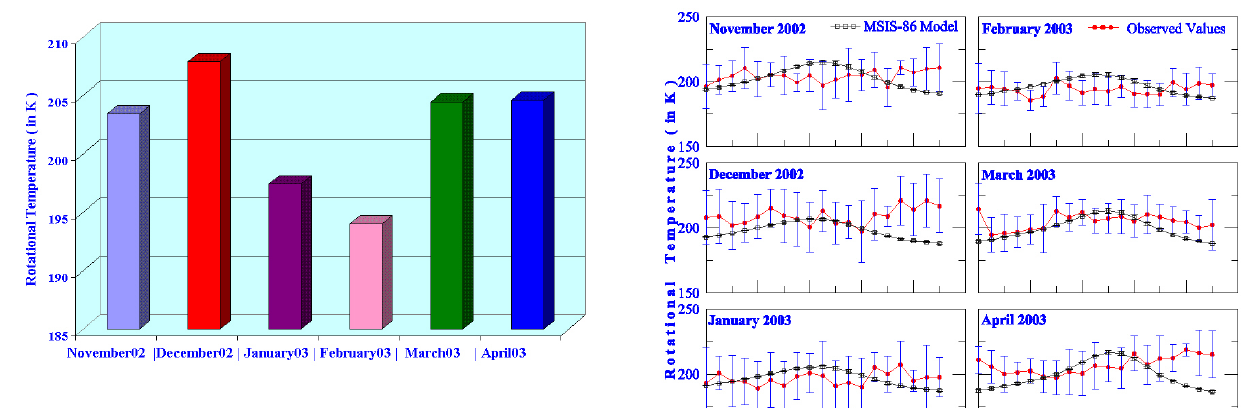
Fig. 5. Monthly mean rotational temperature observed at Kolhapur during November 2002 to April 2003.